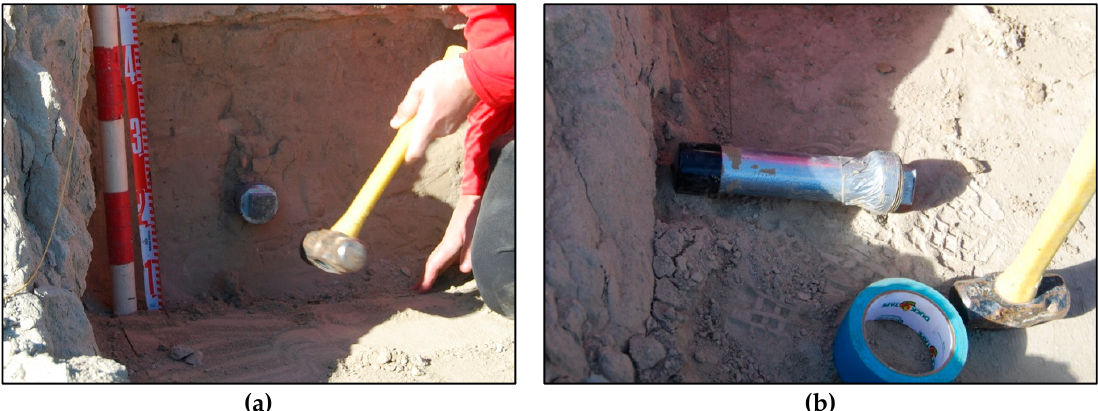
Figure 8. OSL sampling of CCMS-OSL-01: ( a ) Illustrates the sample tube being driven into the target sediments; ( b ) Shows the sample tube after retrieval and capping.